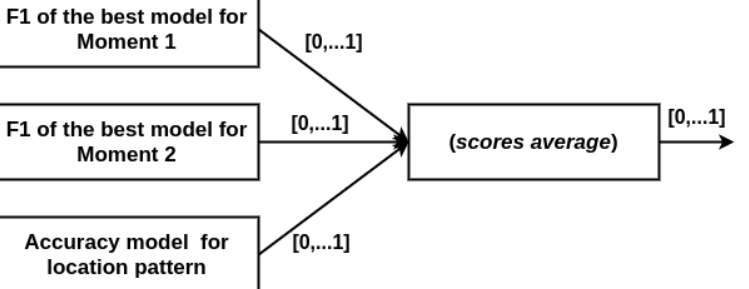
Figure 5. Diagram for the fusion of